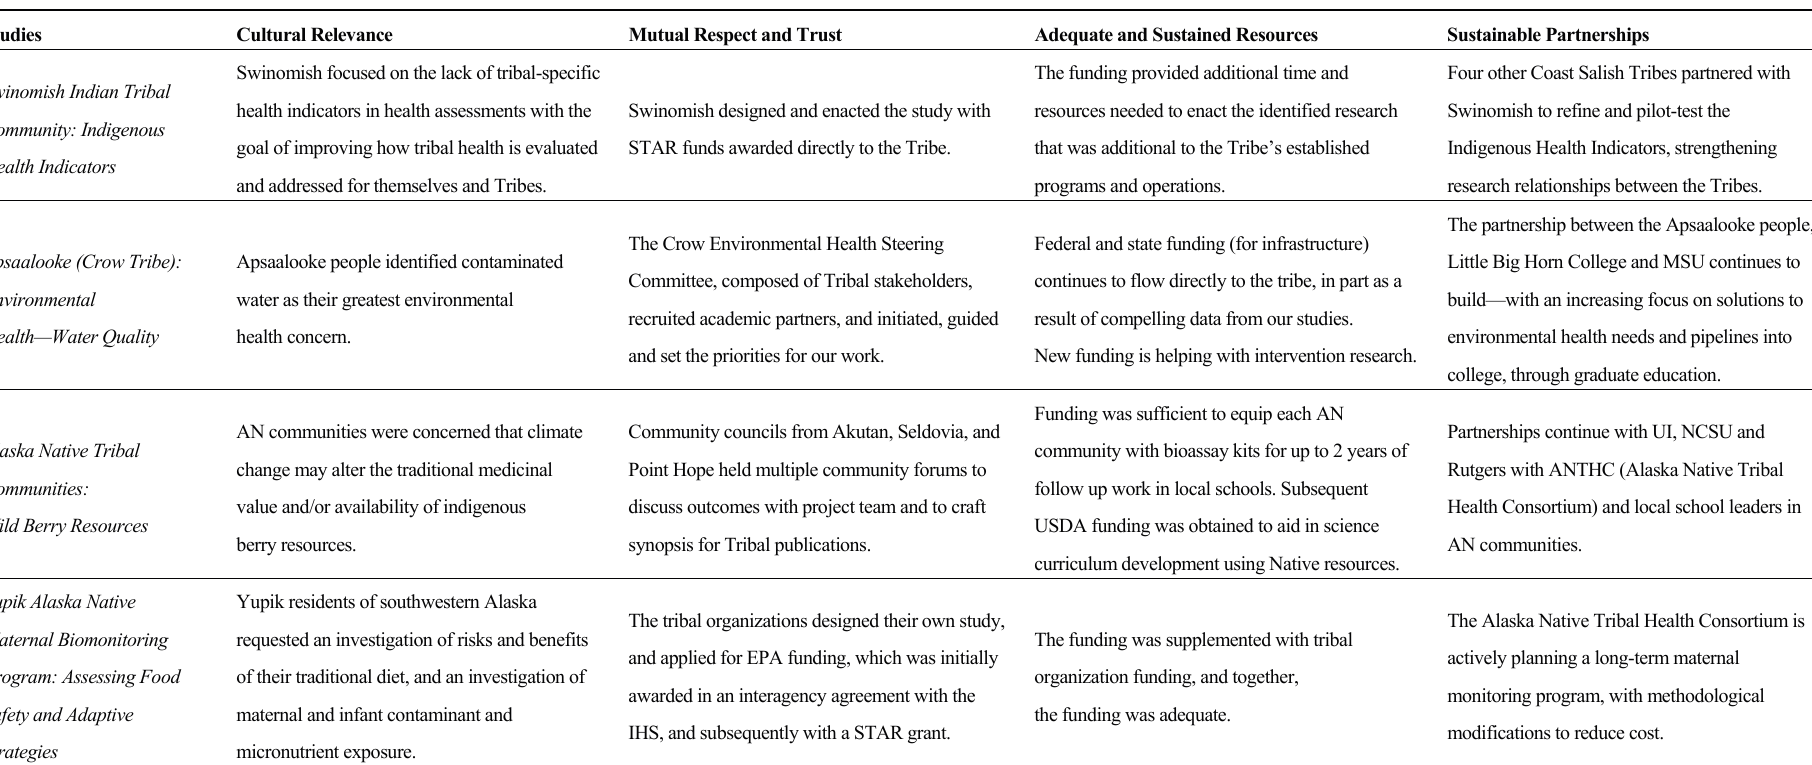
Table 1. Important factors identified in case studies for successful and sustained community-based